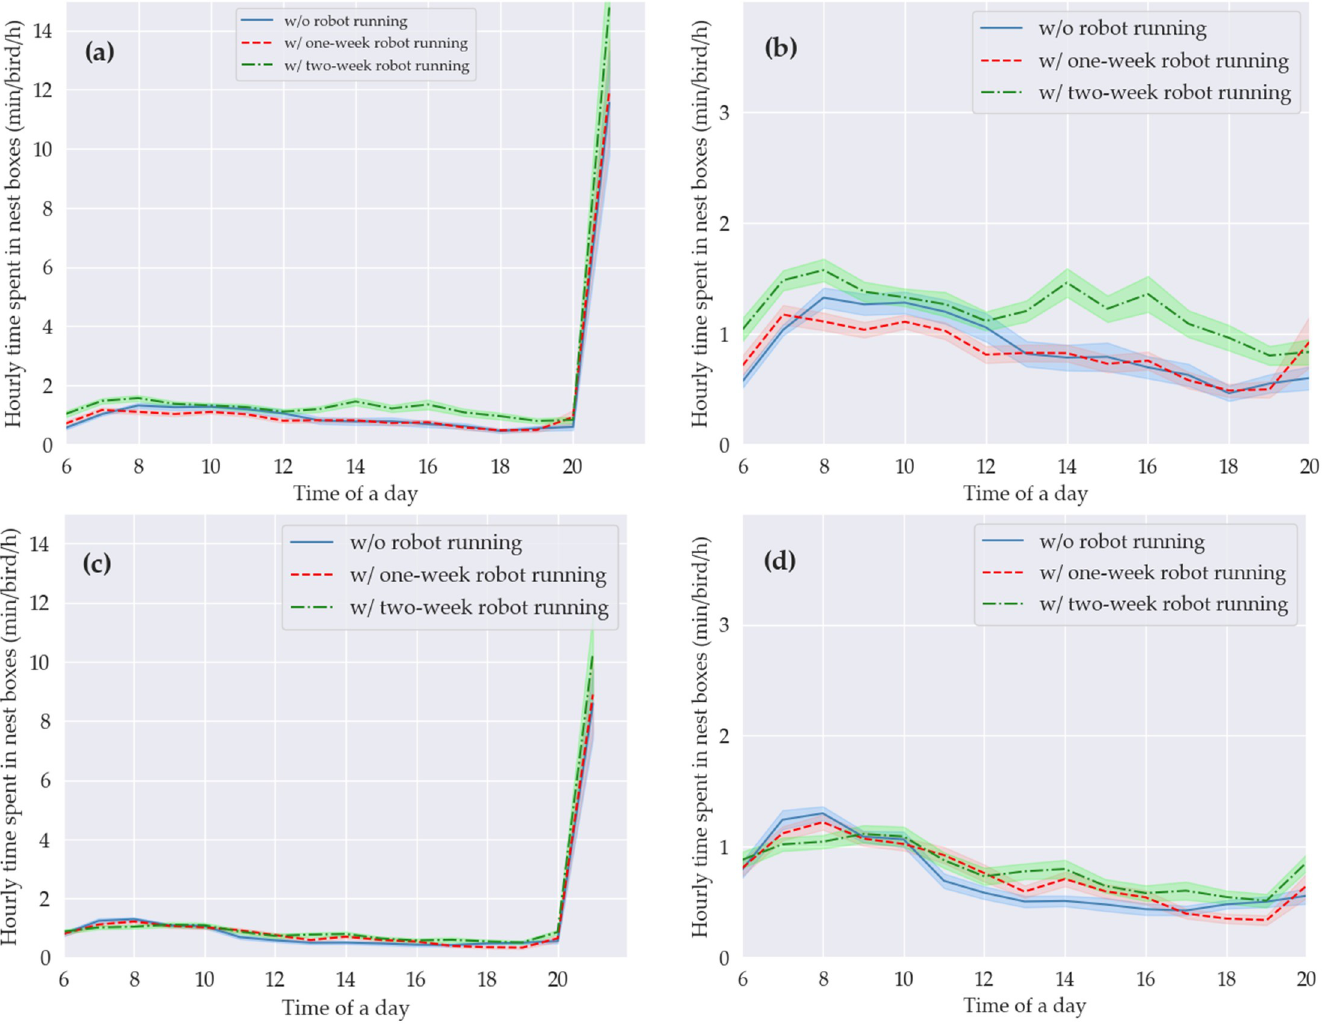
Fig 6. Hourly time spent in nest boxes. (a) From 6:00 to 21:00 in weeks 35–38; (b) from 6:00 to 20:00 in weeks 35–38; (c) from 6:00 to 21:00 in weeks 40–43; and (d) from 6:00 to 20:00 in weeks 40–43. Each value is the average of 4 values, and shading areas represent pooled standard errors of the means. ‘w/’ and ‘w/o’ represent with and without,